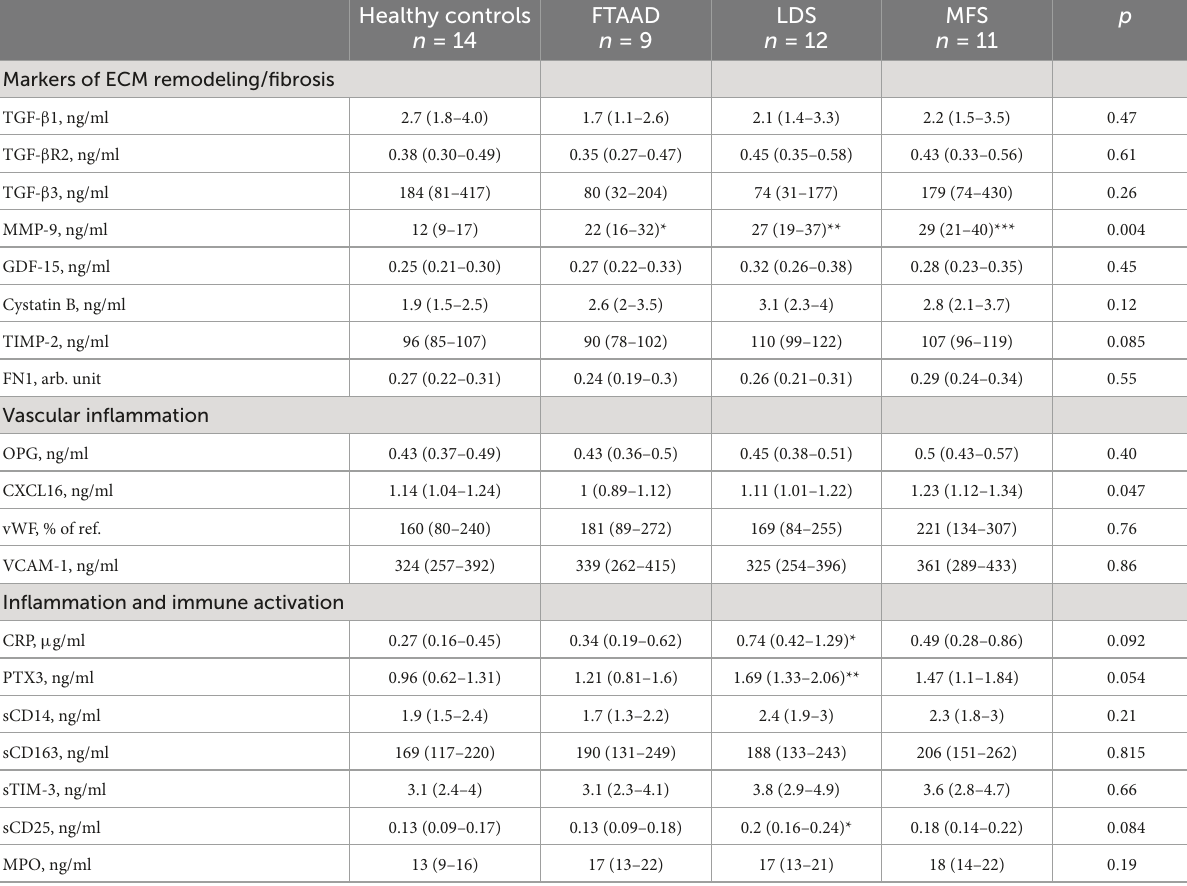
TABLE 3 Results from enzyme immunoassays (EIA) analyses of the main findings.